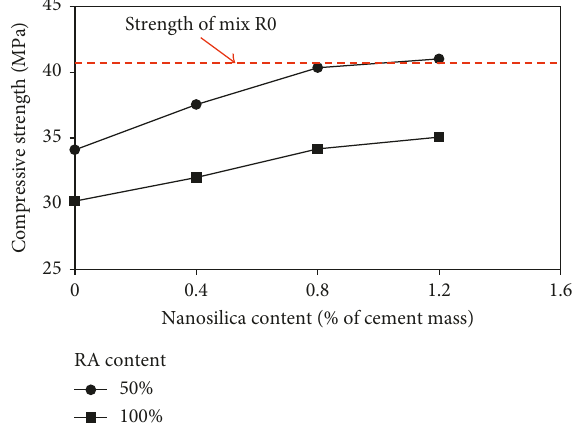
Figure 4: Effect of nanosilica particle content on the compressive strength of RAC